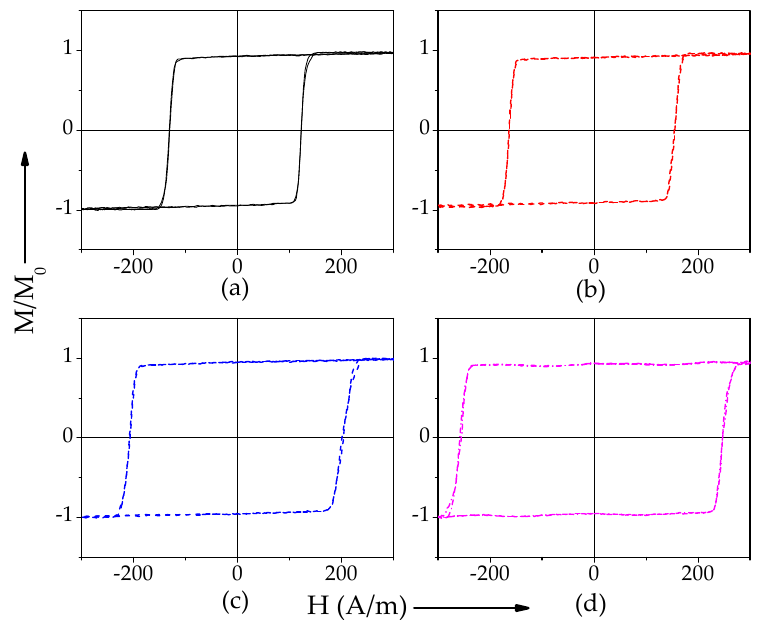
Figure 13. Hysteresis loops of as-prepared ( a ) and annealed for 4 min ( b ), 16 min ( c ), and 32 min ( d )